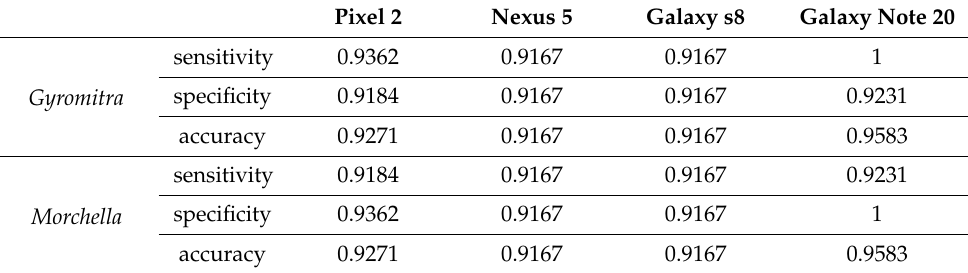
Table 2. Inter-phone testing results—2 classes.